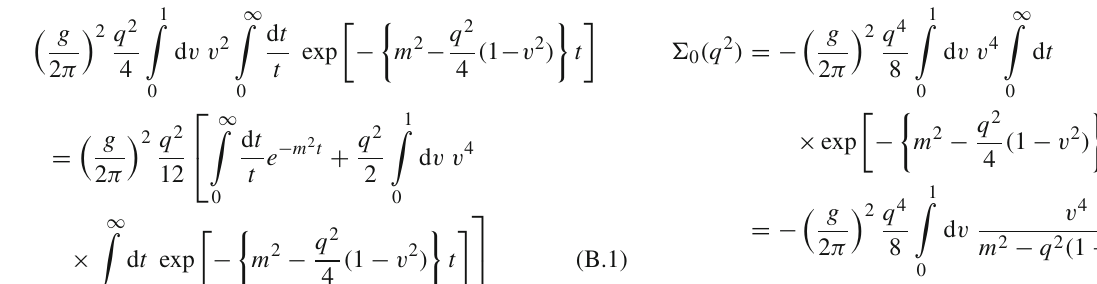
Fig. 2 Closed contour in u plane in both first and fourth